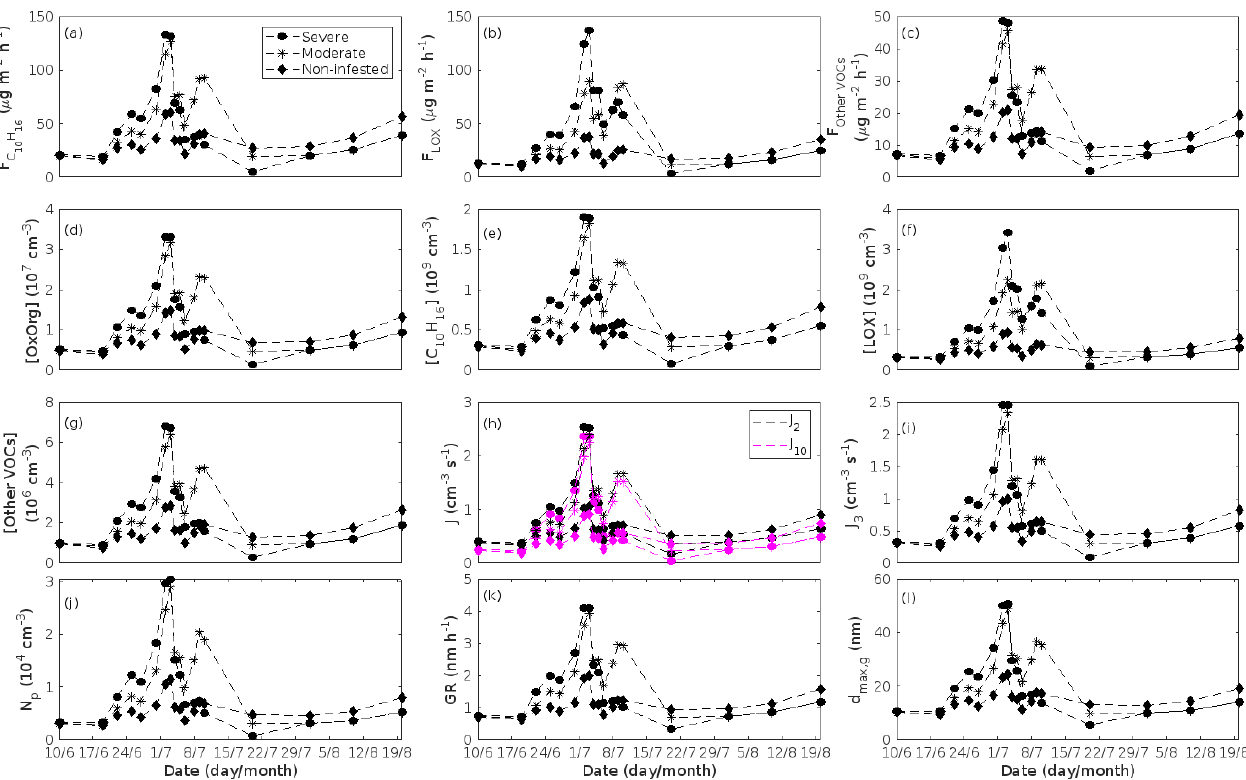
Figure 9. A pure mountain birch stand infested with autumnal moth larvae in comparison to a non-infested pure mountain birch stand. Canopy emissions of (a) monoterpenes, (b) lipoxygenase pathway volatiles, and (c) the sum of other VOCs that contribute to OxOrg formation (here i.e. dimethyl-nonatriene and sesquiterpenes). Atmospheric concentrations of (d) OxOrg, (e) monoterpenes, (f) lipoxygenase pathway volatiles, and (g) the sum of other VOCs which contribute to OxOrg formation. Formation rates of (h) 2, 10, and (i) 3nm particles. (j) Number concentrations of formed particles. (k) Growth rates of newly formed particles. (l) Daily maxima diameter of the growing particle mode. “Moderately” and “severely” refer to 30% and 80%, respectively, of the leaf area that has been consumed by the end of the feeding